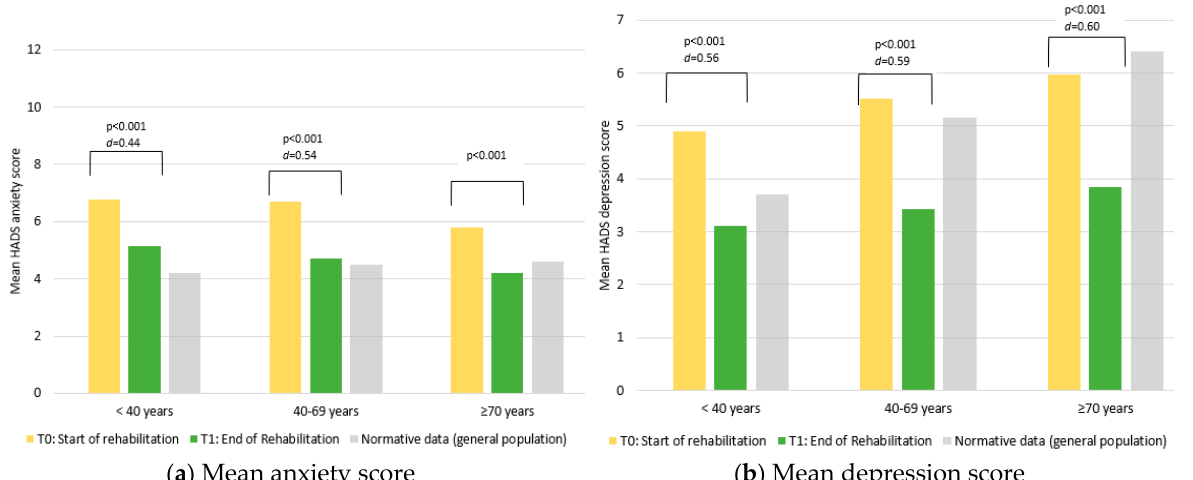
Figure 1. Mean HADS anxiety and depression scores ( a , b ), stratified by age groups, compared to data from the general population [62].